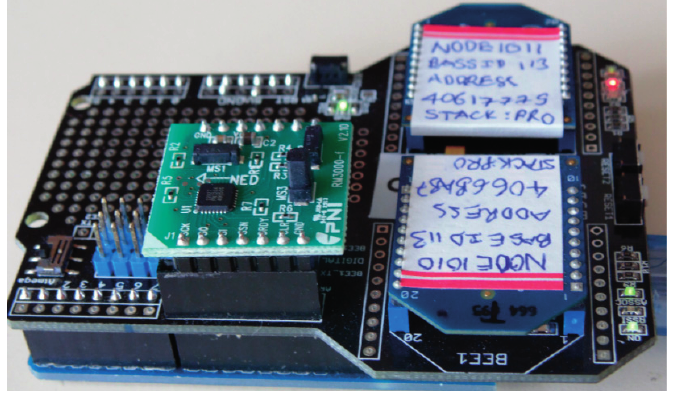
Figure 7. Microprocessor board with RM3000 sensor